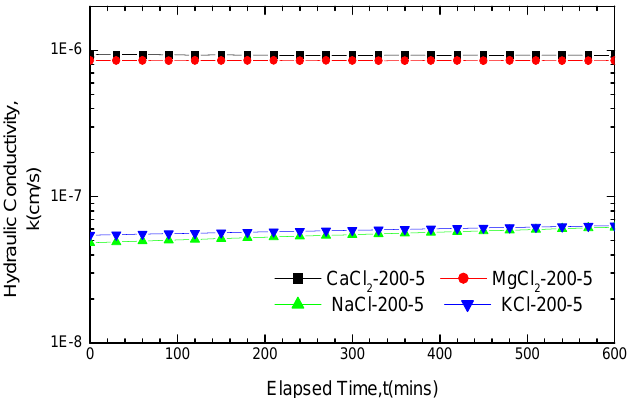
Figure 3. Hydraulic conductivity results for GCL specimens soaked with 200 mM solutions for five days and permeated with the same solutions after